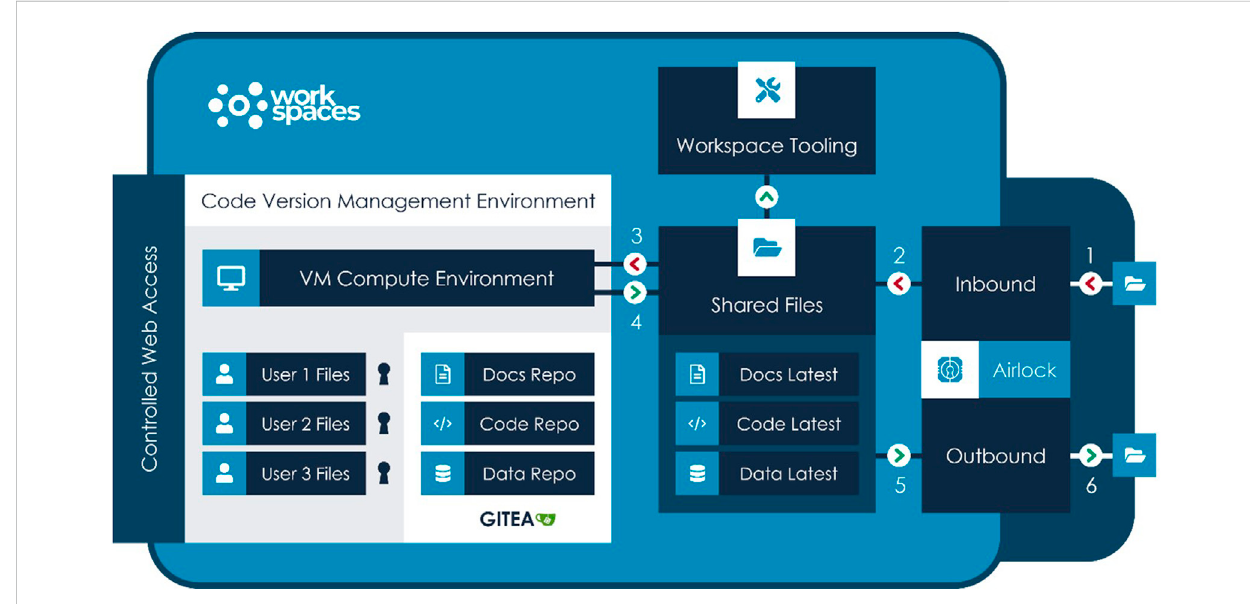
FIGURE 2 Diagram illustrating a typical fl ow for development and review purposes based on the Aridhia DRE Workspace Environment.